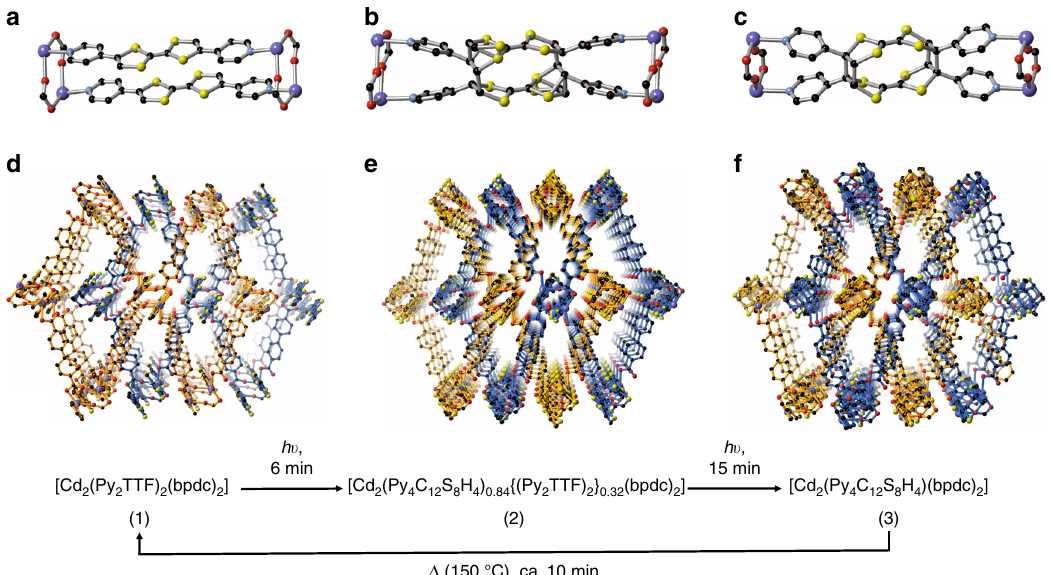
Fig. 1 Effect of light irradiation on the structure of 1. The cofacially arranged Py 2 TTF moieties of ( a ) 1 , ( b ) 2 and ( c ) 3 experience an unprecedented double [2 + 2] photocyclisation reaction. The view down the c -axis of ( d ) 1 , ( e ) 2 and ( f ) 3 . The two independent nets have been highlighted in orange and blue. The coloured spheres represent C (black), N (light blue), O (red), S (yellow) and Cd (violet). Hydrogen atoms and solvent molecules in each of the frameworks have been omitted for